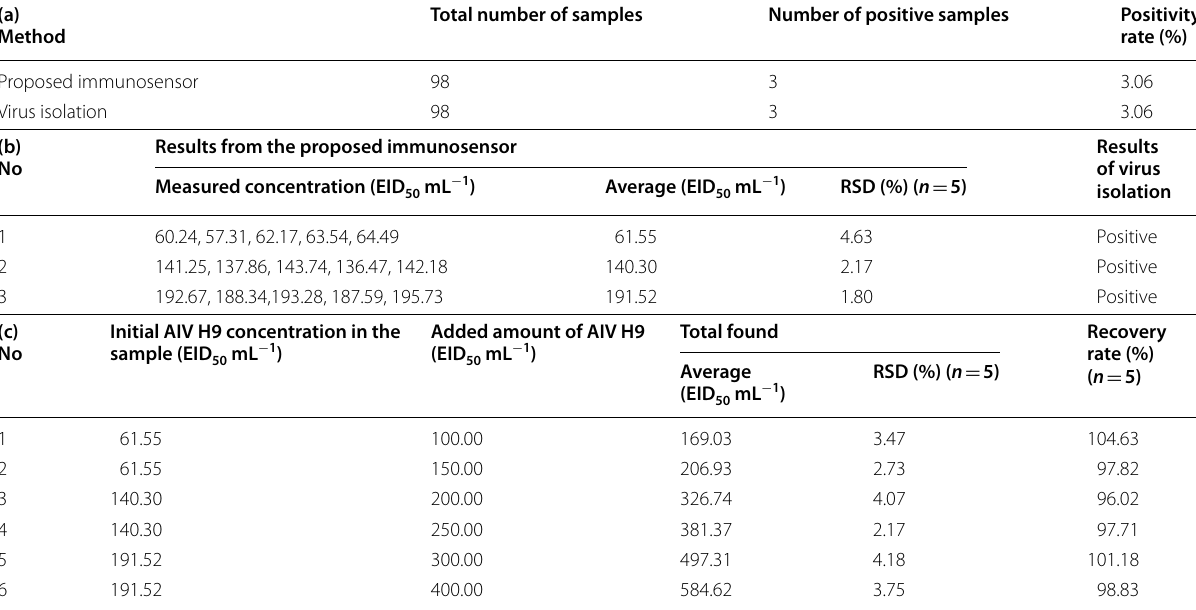
Table 3 Results from clinical samples (a); results from the analysis of positive samples (b); and results for the recovery of different concentrations of AIV H9 from clinical samples